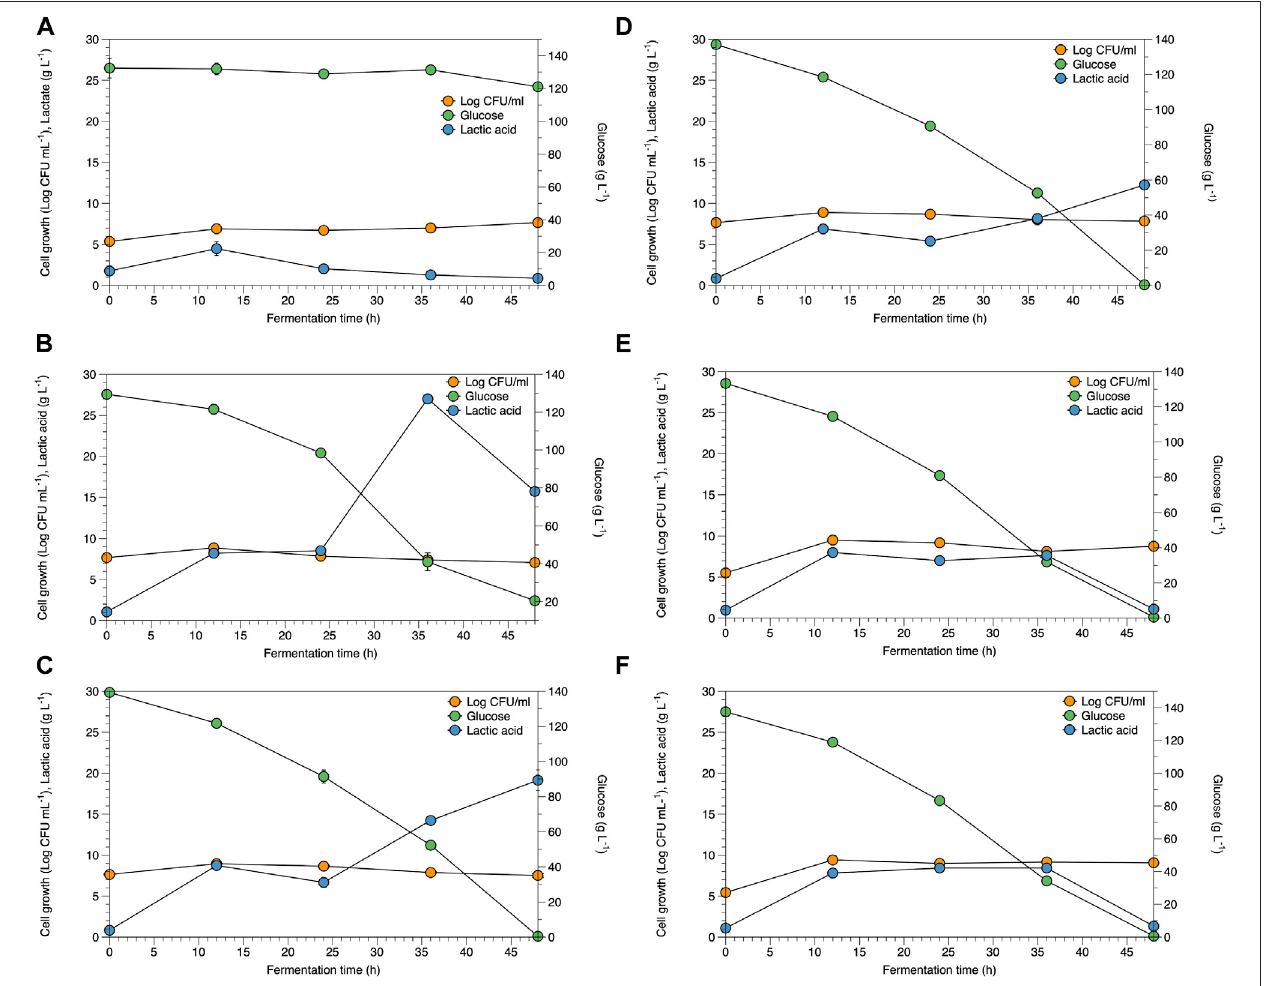
FIGURE1| Timecourseof B.coagulans ATCC7050growthandlactateproductionundervariousconditionsas (A) control, (B) WCR20 gL − 1 , (C) WCR40 gL − 1